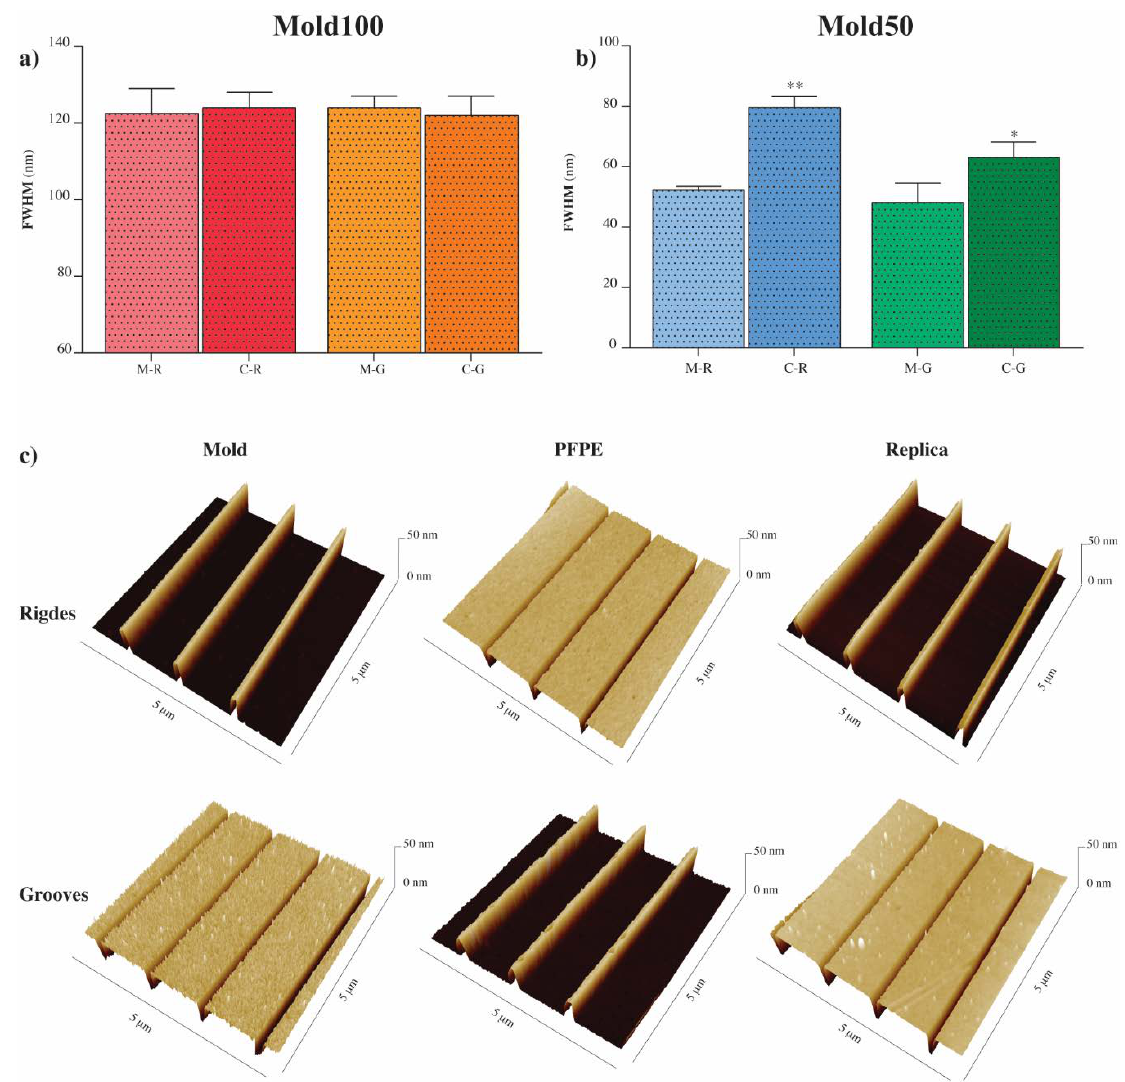
Figure 3. Atomic force microscopy measurements Mold100, Mold50, PFPE intermediate molds and COC final replicas. ( a ) FWHM of Mold100 ridges (M-R) and grooves (M-G), and respective COC replica ridges (C-R) and grooves (C-G). ( b ) FWHM of Mold50 ridges (M-R) and grooves (M-G) and respective COC replica ridges (C-R) and grooves (C-G). Data in ( a , b ) are mean ± SD, */** p < 0.05/0.01, unpaired t -test. ( c ) Representative 3D AFM images for ridges and grooves of the Mold100, PFPE intermediate mold, and COC final replica.